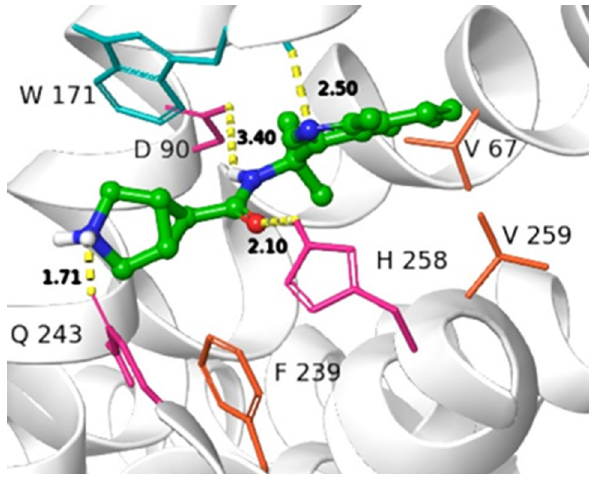
Fig. 5 Predicted binding mode of an MCL prototype (MCL-80) in our earlier βAR-based published sst model. Compound is colored 4 by atom-type, while the interacting residues are represented as sticks. The hydrogen bonds are yellow dotted